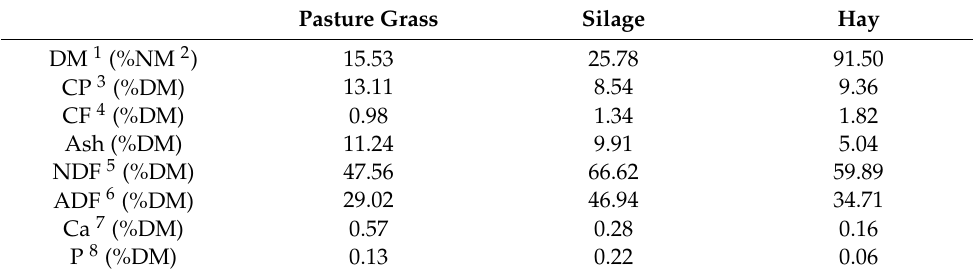
Table 1. Chemical composition: pasture grass, silage, and hay (as fed). Pasture Grass Silage Hay DM 1 (%NM 2